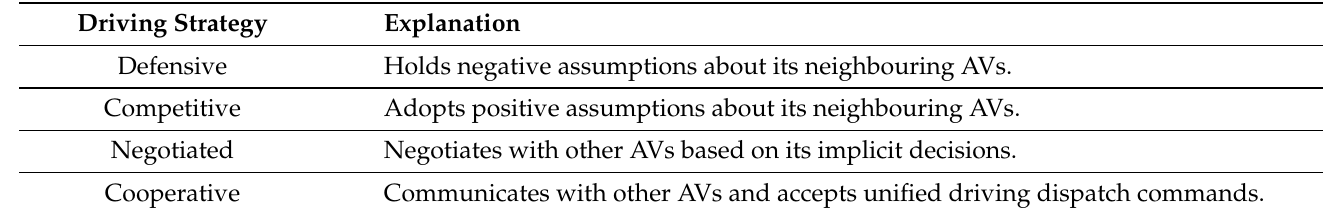
Table 9. Types of driving